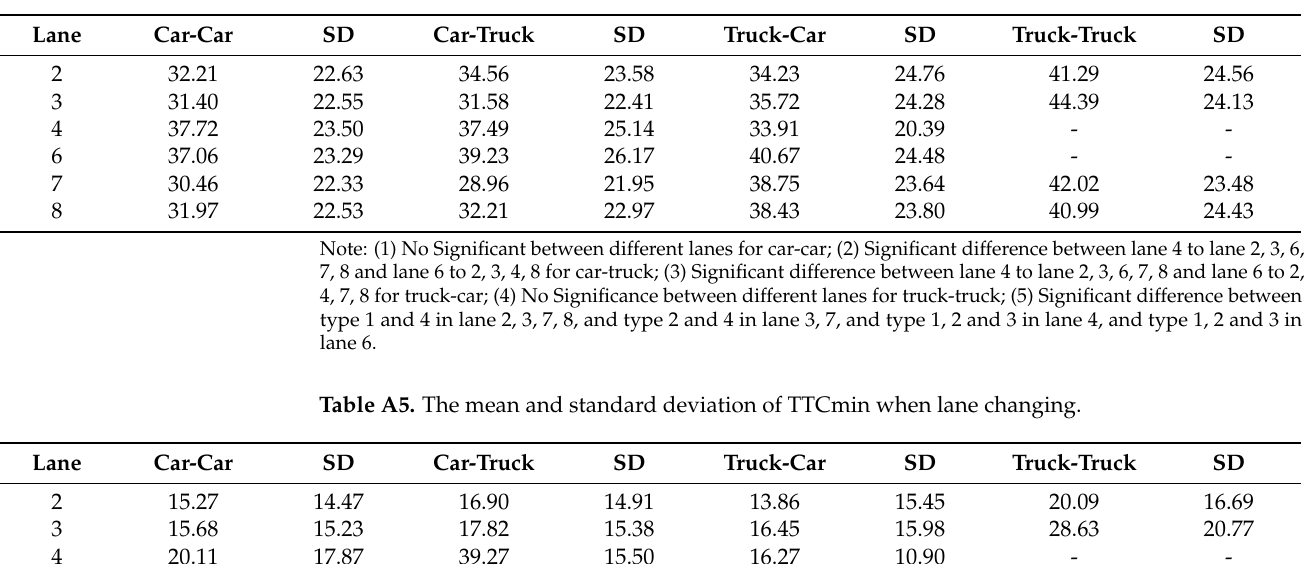
Table A4. The mean and standard deviation of TTCmin when car following.